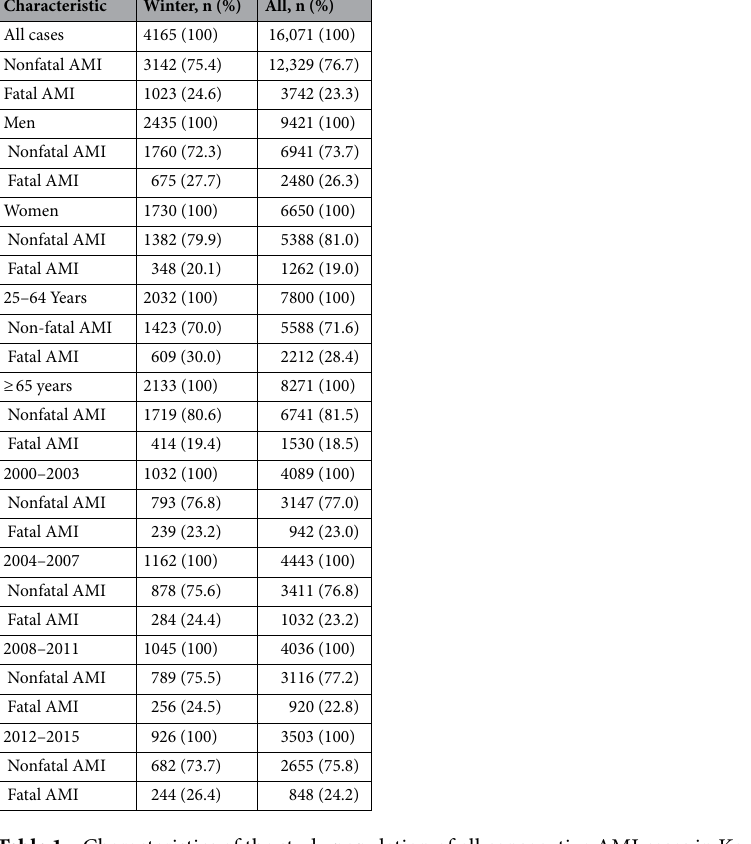
Table 1. Characteristics of the study population of all consecutive AMI cases in Kaunas during the study years 2000–2015, by type of AMI, age, sex and time